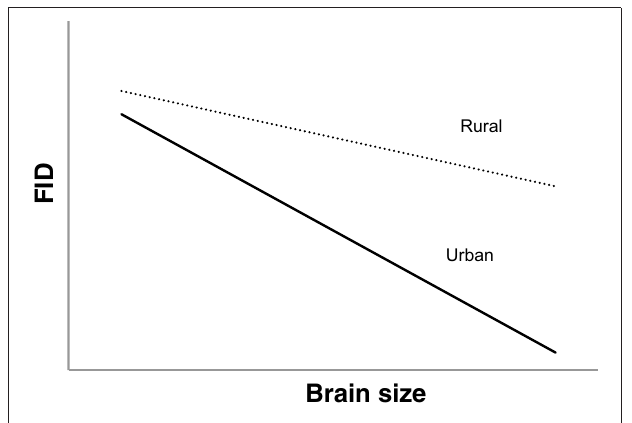
FIGURE 1 | Predicted interspecific relationships between relative brain size and FID in rural (dotted line) and urban birds (solid line) if larger brained birds are better able to adjust to human presence. The pattern demonstrates an interaction between habitat and brain size in predicting FID.